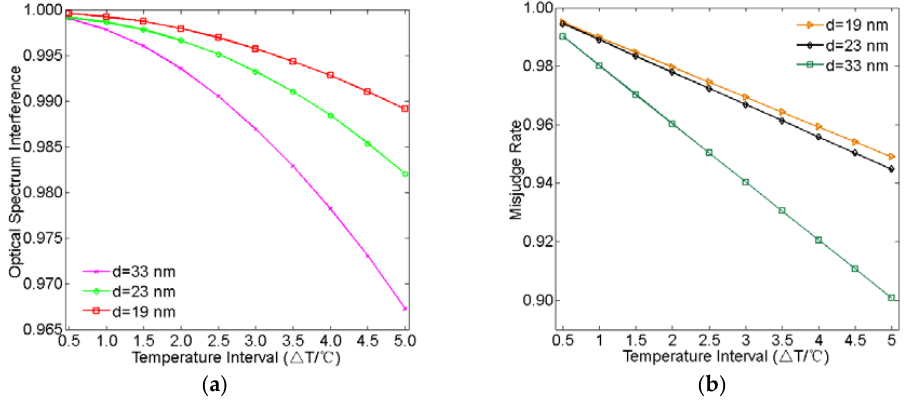
Figure 10. ( a ) Optical spectrum interference and ( b ) misjudge rate as a function of temperature interval for d = 33 nm, 23 nm, and 19 nm, respectively.